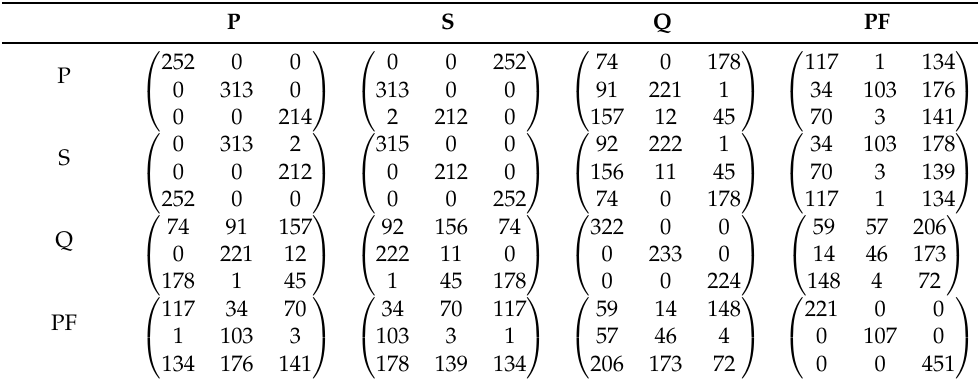
Table 2. Coincidence table between classifications obtained with the extended variables in Scenario